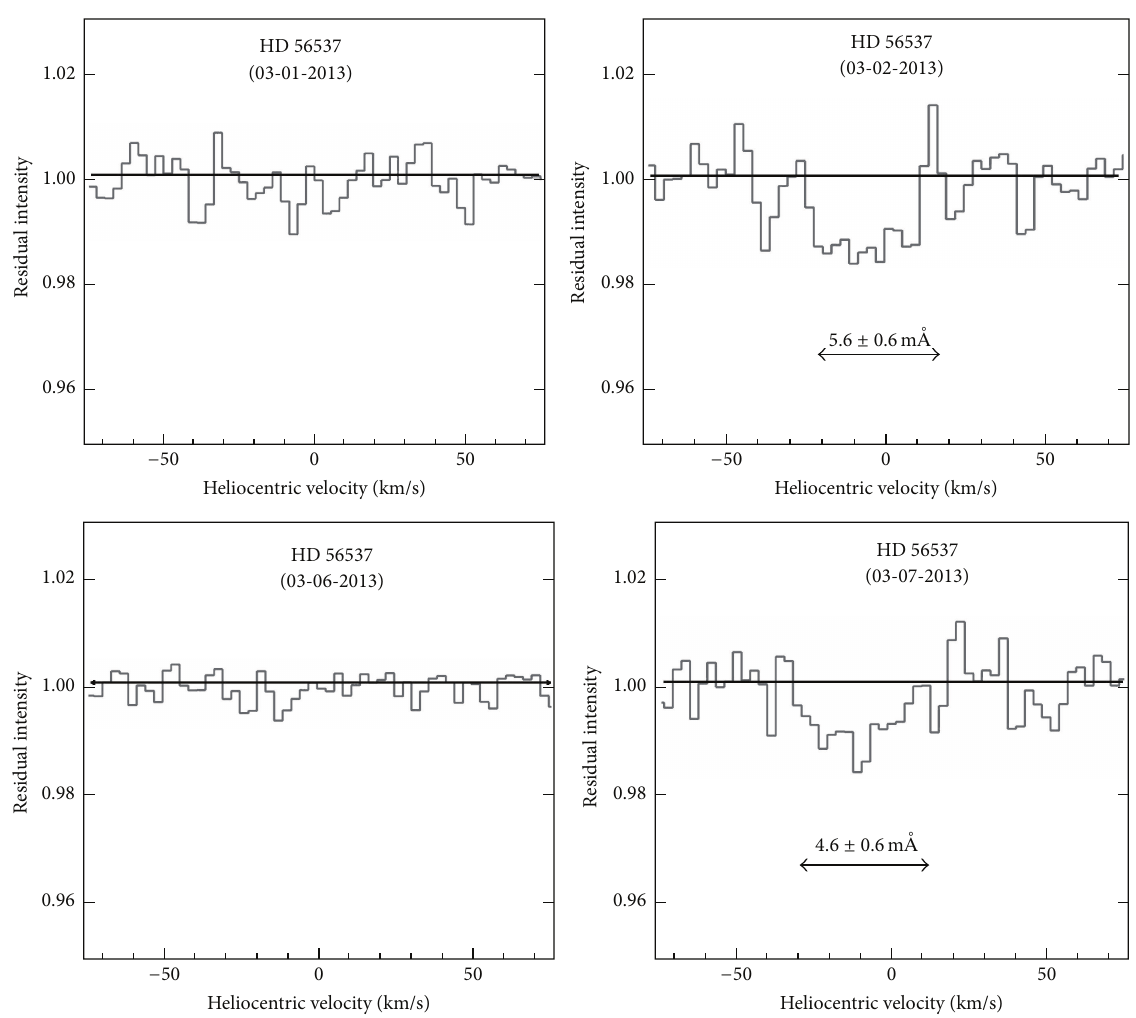
Figure 2: The circumstellar CaII K-line absorption spectra of HD 56537 recorded on 4 nights in March 2013. Note the appearance, disappearance, and reappearance of an absorption feature centered at 𝑉 ∼ −10 kms −1 over a 6-day